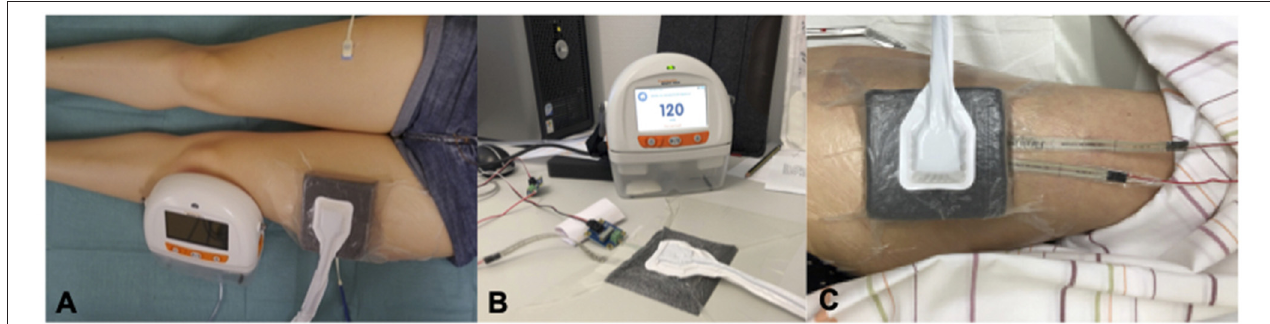
FIGURE 1 | Study Set-up. (A) Microcirculatory Analysis via two O2C-probes under an applied NPWT-dressing and on the contralateral thigh. (B) Calibration-process of pressure probes under controlled conditions on a firm surface. (C) Analysis of surface pressure under an applied NPWT-dressing via two probes located central/marginal.